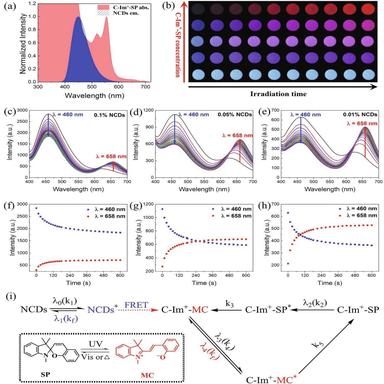
Dynamic fluorescence phenomenon and kinetics process of CDs@C-Im+-SP solid-state materials. (a) Overlap between the emission spectrum of NCDs and the absorption spectrum of C-Im+-SP. (b) Fluorescent images of CDs@C-Im+-SP with different C-Im+-SP concentration and different irradiation time (λex = 365 nm). (ch) Fluorescence spectra and intensity at 460 and 658 nm of CDs@C-Im+-SP with NCDs concentration of (c, f) 0.1%, (d, g) 0.05% and (e, h) 0.01% as the increase of irradiation time (λex = 365 nm). (i) Fluor